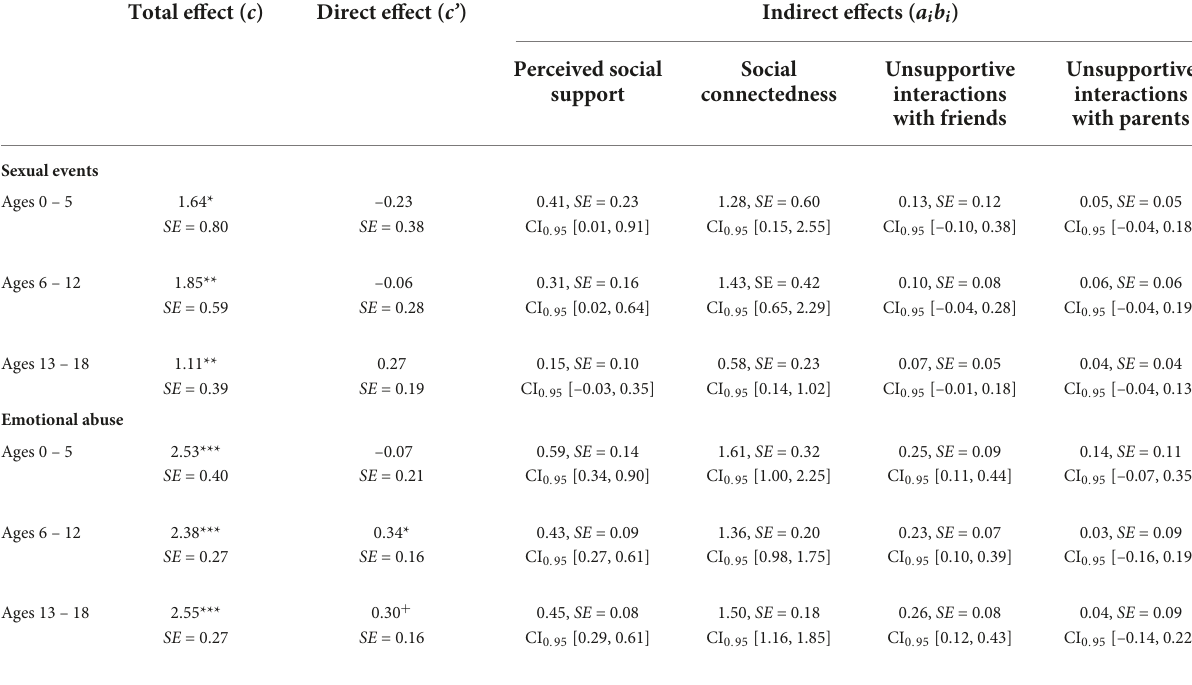
TABLE 5 Mediation models of the relations between early life events and loneliness mediated by social factors across the three age ranges in Study